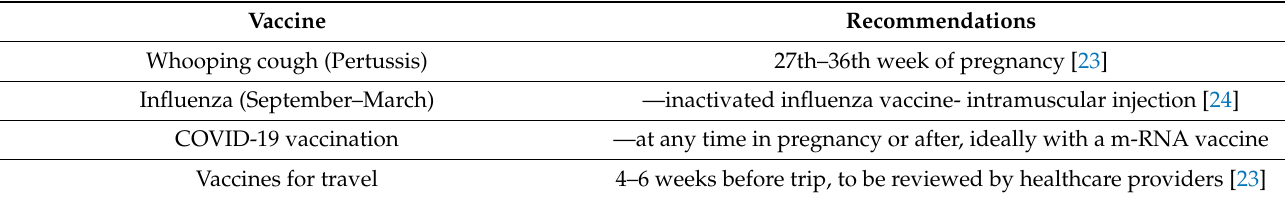
Table 1. Vaccines in women with MG recommended during pregnancy and